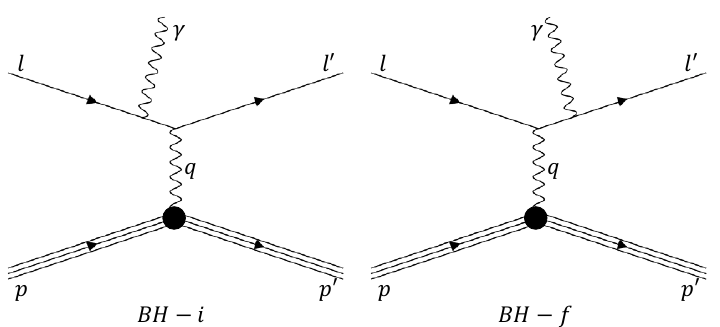
Figure 2. Feynman diagrams for the initial state ( left panel, BH-i), and the final state ( right panel, BH-f) Bethe-Heitler